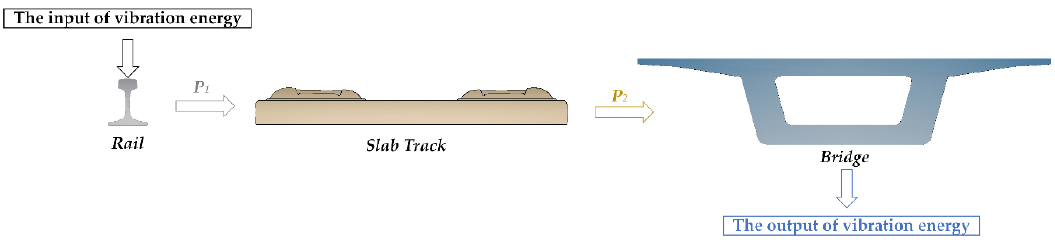
Figure 4. The transfer of vibration energy.